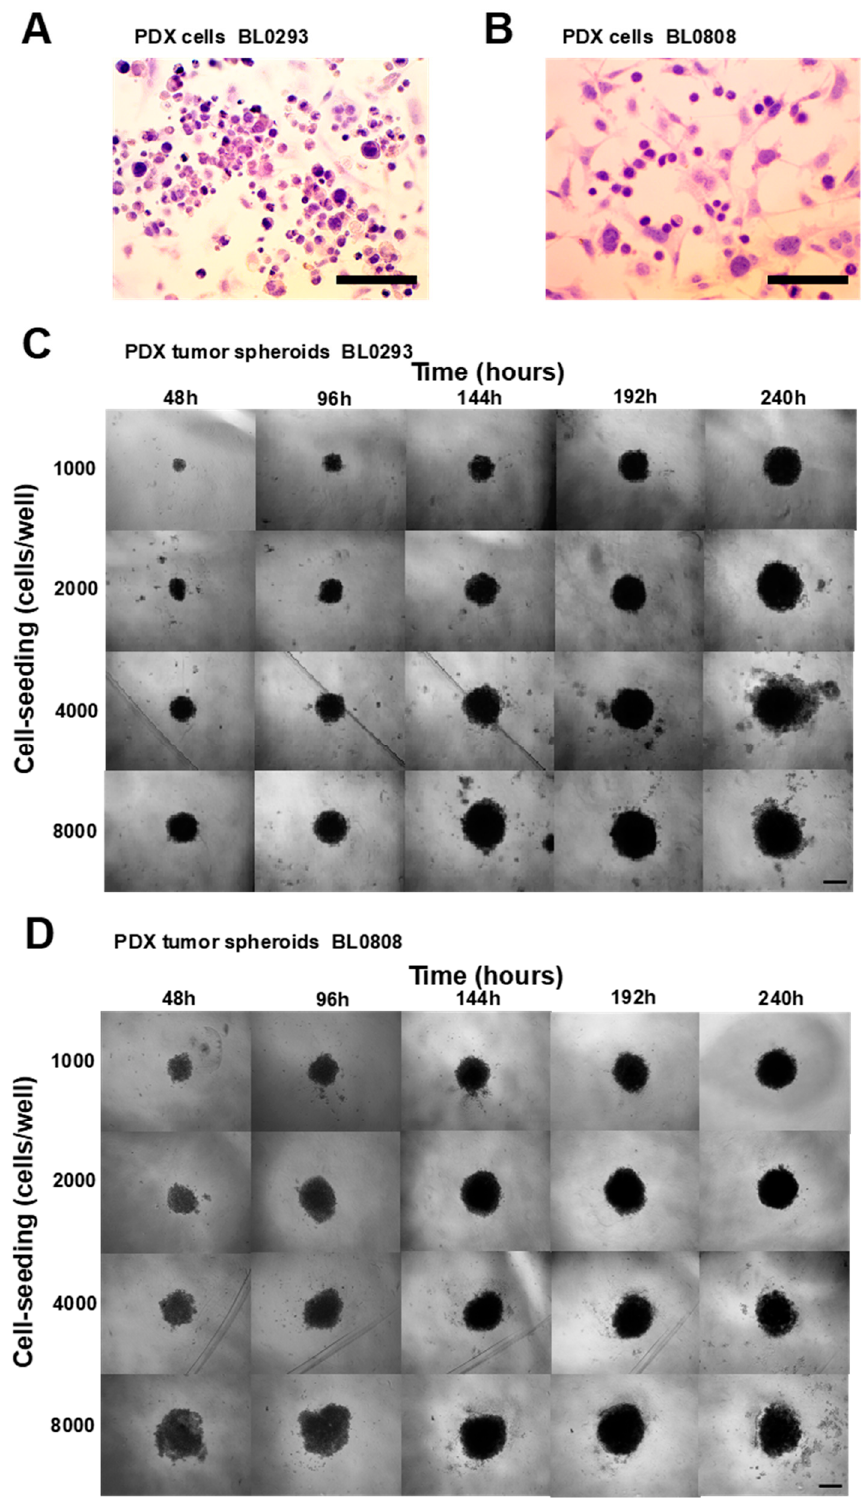
Figure 1. Bright-field microscopic images of patient-derived xenograft (PDX) tumor cells BL0293 ( A ) e BL0808 ( B ) stained with hematoxylin and eosin (tumor cells purplish/bluish-colored and fibroblasts pinkish-colored); 40× magnification, scale bar = 100 μ m. Phase-contrast microscopic images of PDX tumor spheroids BL0293 ( C ) and BL0808 ( D ) at different cell-seeding concentrations, cultured for 10 days; 10× magnification, scale bar = 500 μ m.